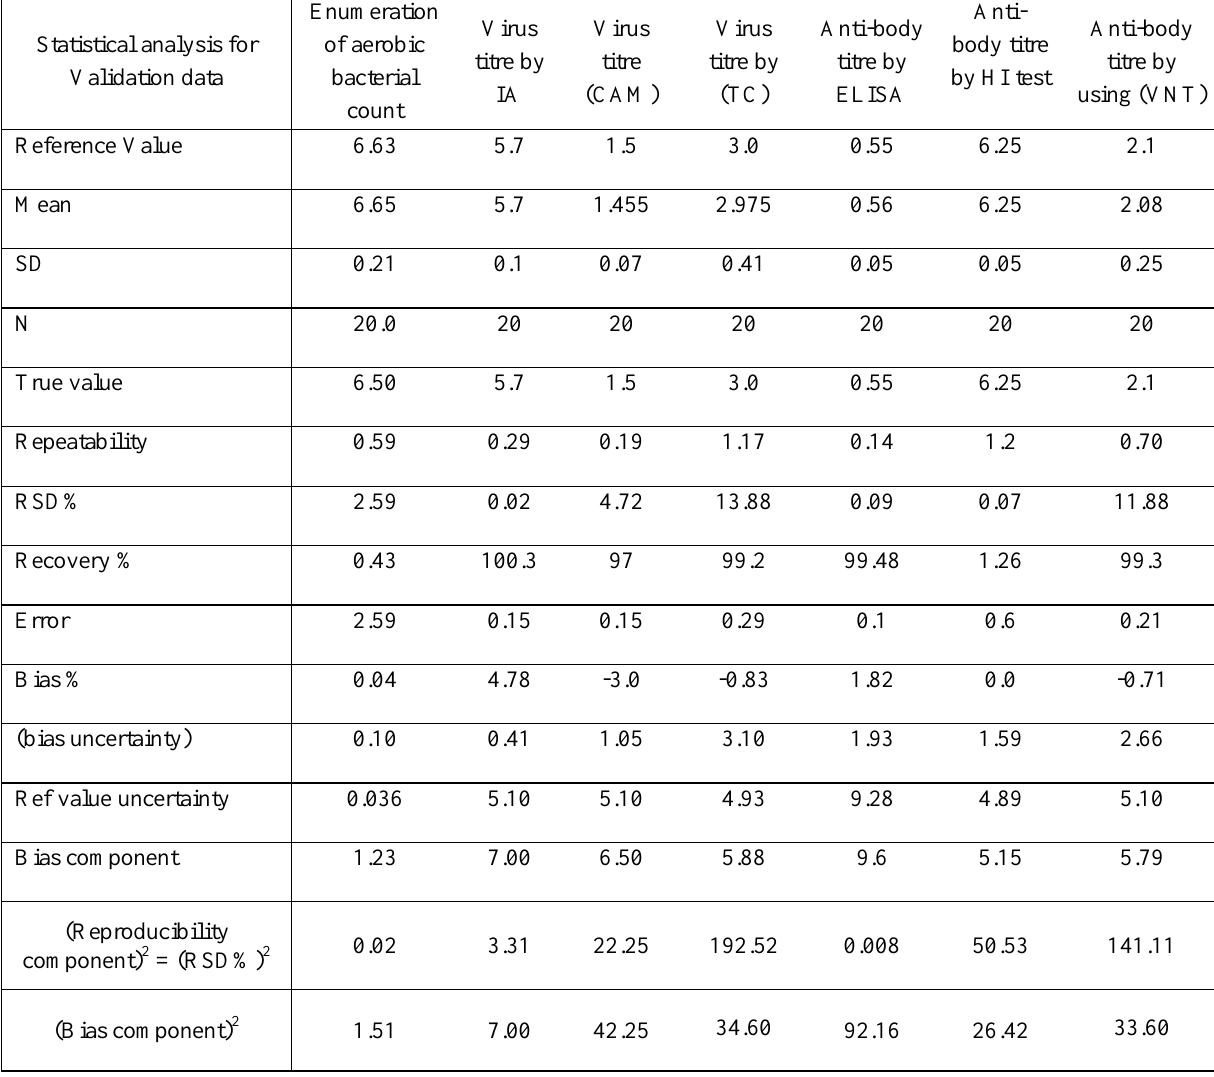
Table 1: Statistical Evaluation of Results for different 7 methods.